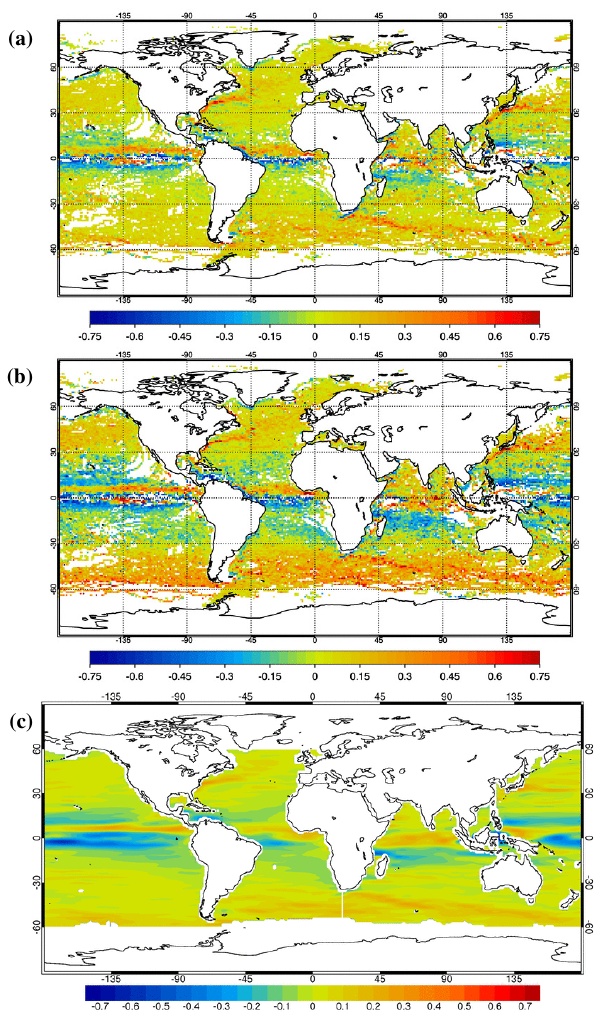
Figure 5: Average zonal velocity fields over the 2007-08 study period in 1º bins: (a) Fig. 5. Average zonal velocity fields over the 2007–2008 study pe- FOAM model values and (b) drifter-derived observation values at riod in 1 ◦ bins: (a) FOAM model values and (b) drifter-derived ob- observation points. The corresponding averaged OSCAR zonal velocity is servation values at observation points. The corresponding averaged shown in (c). OSCAR zonal velocity is shown in (c)